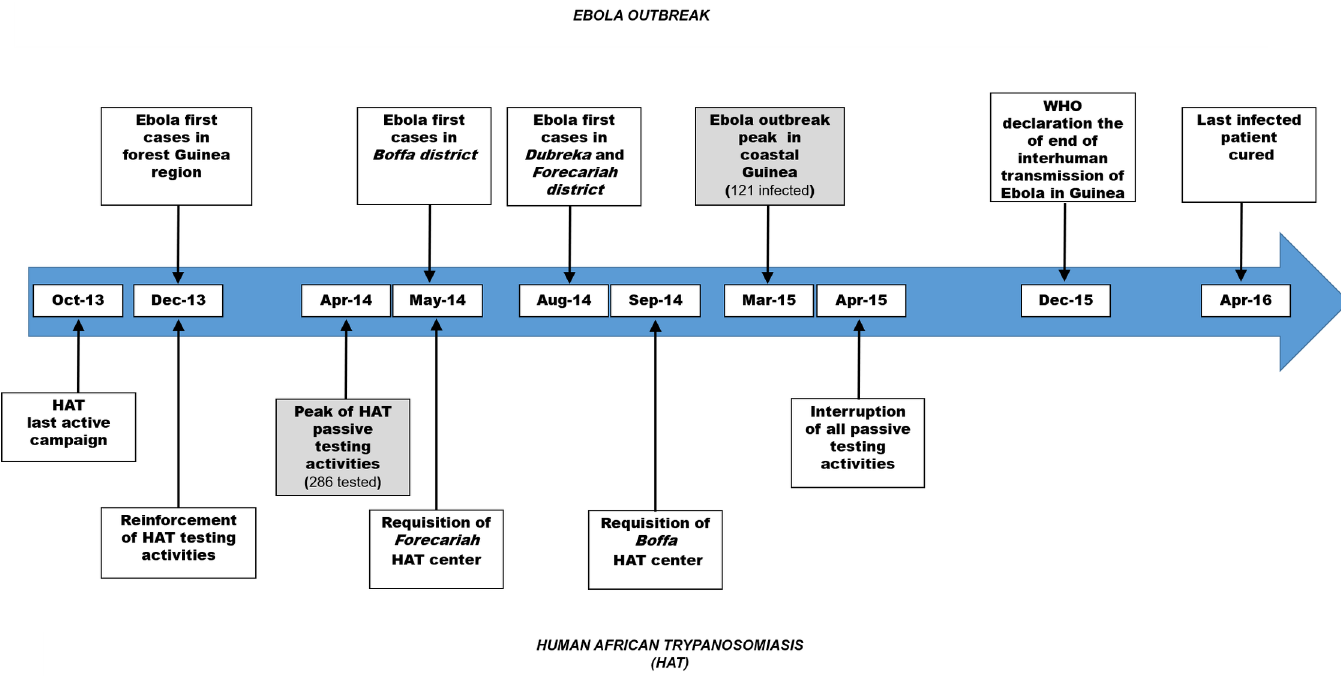
Fig 2. Timeline of the Ebola epidemic and HAT control activities. This figure shows in parallelthe main events of the Ebola epidemic and of Human African Trypanosomiasis (HAT) control activities betweenOctober 2013 and April